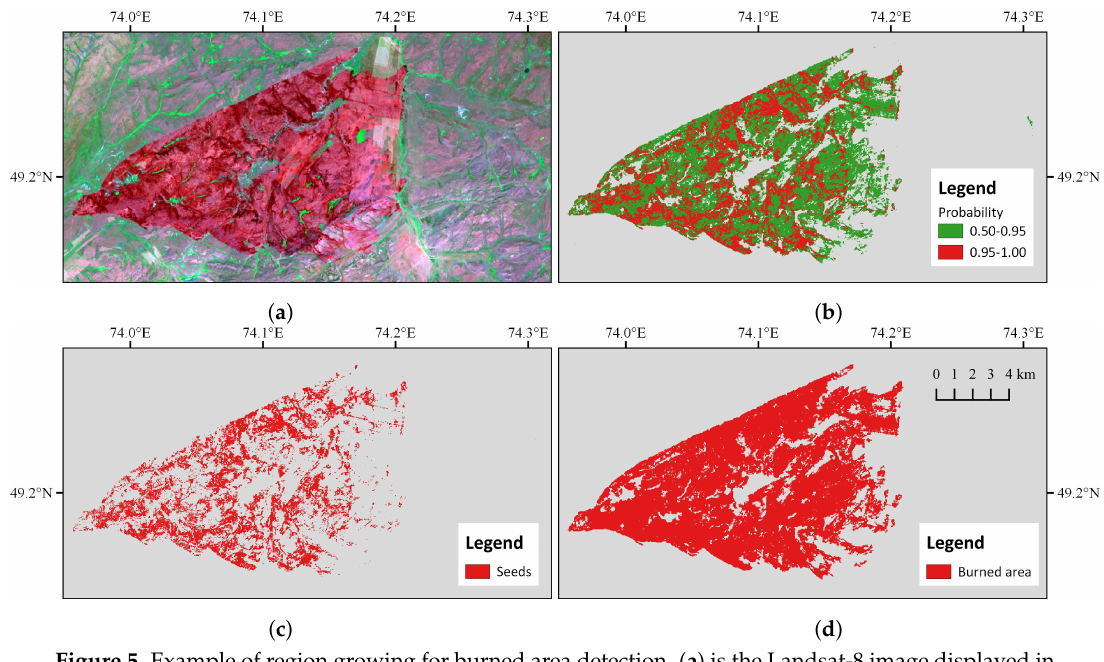
Figure 5. Example of region growing for burned area detection. ( a ) is the Landsat-8 image displayed in false color composition (red: SWIR2 band, green: NIR band, and blue: green band); ( b ) is the map of burned probability generated by the proposed method; ( c ) is the candidate seeds of burned area; ( d ) shows the final burned area map after region